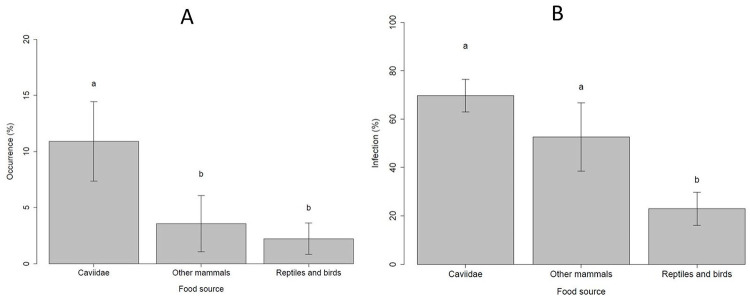
(A) Frequency of occurrence (%) of Triatoma brasiliensis on different food sources. (B) Infection rates (%) of Triatoma brasiliensis by Trypanosoma cruzi fed on the different food sources analyzed in several sites of Rio Grande do Norte (RN) and Paraíba (PB) states, Brazil. Distinct letters point to statistical differences (p<0.05, Tukey).